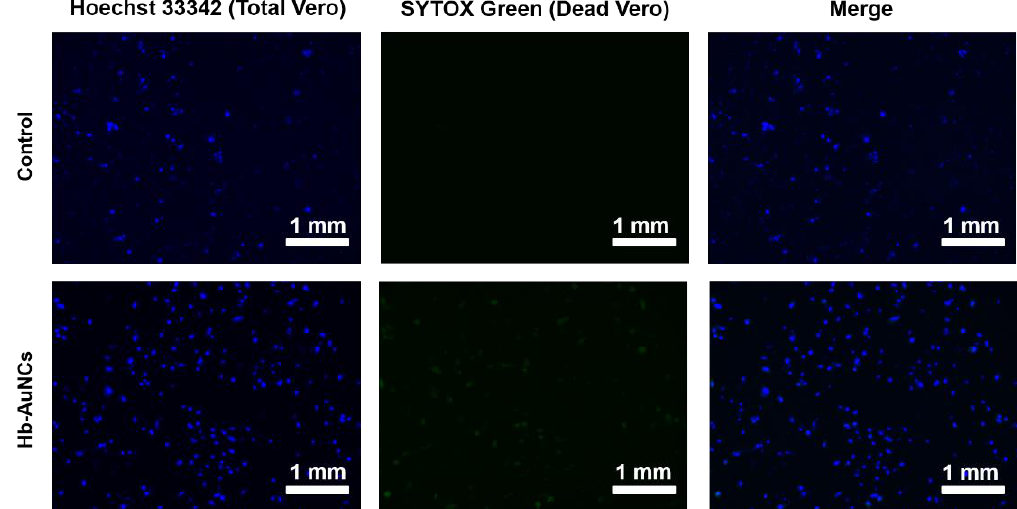
Figure 5. Fluorescence images of Vero cells incubated with hemoglobin-conjugated gold nanoclusters (Hb-AuNCs). In the control experiments, Vero cells were cultured with Dulbecco’s modified Eagle’s medium (DMEM).